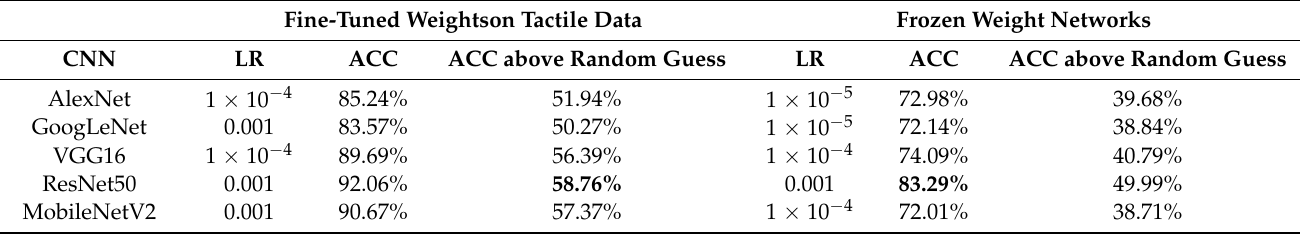
Table 5. Classification results for BiGS data set. All networks are trained on a minimum batch of size 16 and for 10